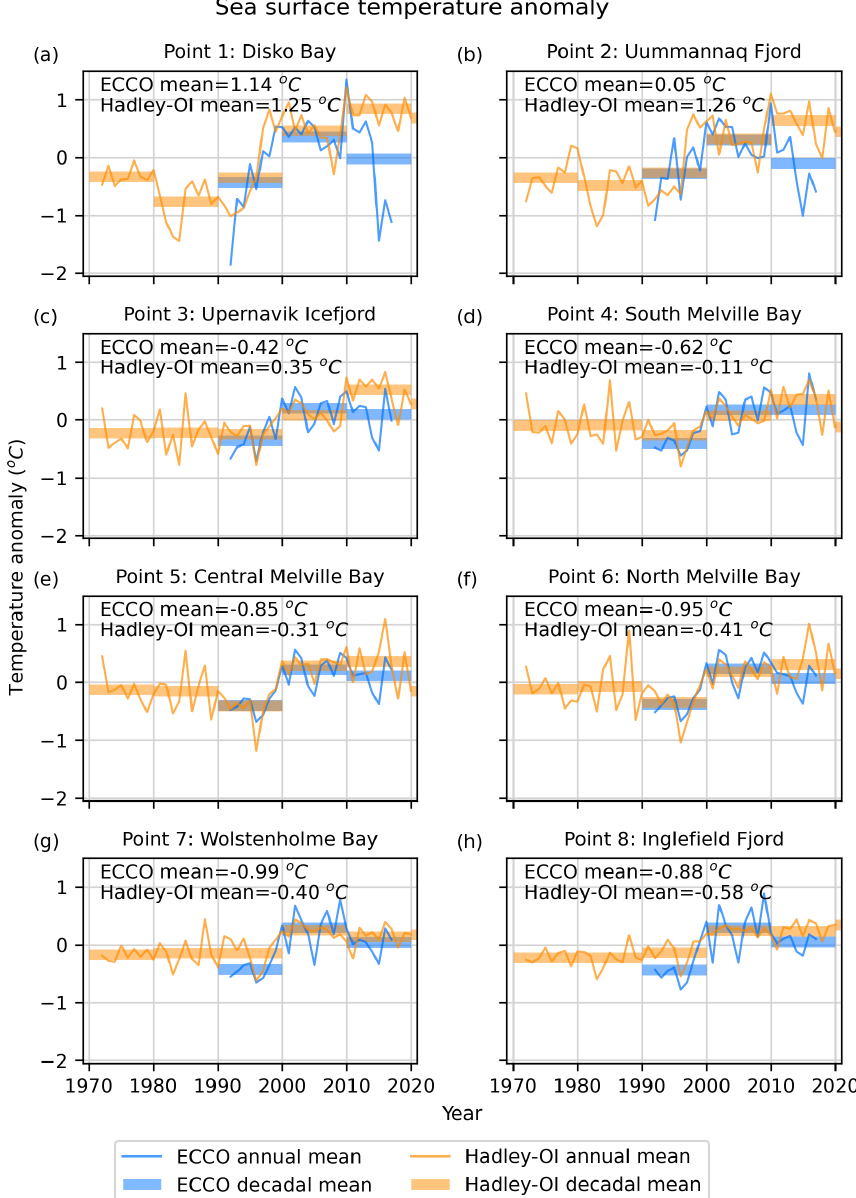
Figure 8. Annual and decadal mean sea-surface temperature anomaly from ECCO (blue) and Hadley-OI (orange). Each panel corresponds with an ocean point in Fig. 1. The mean for each anomaly is reported in each